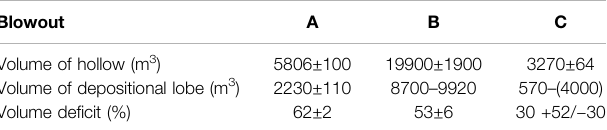
TABLE 2 | Volume de fi cit measurement of the three small